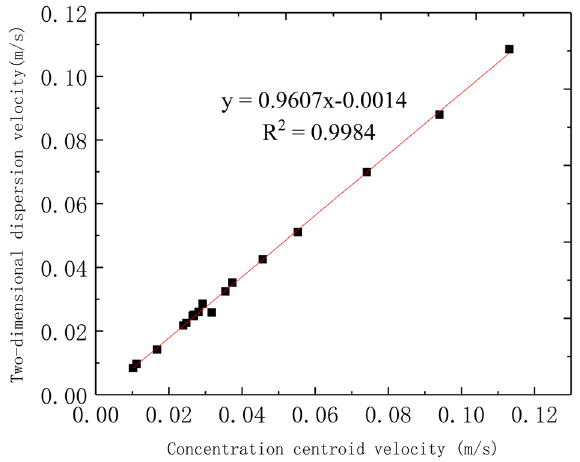
Figure 12. Correlation between concentration centroid method and two-dimensional dispersion numerical model for velocity estimation.